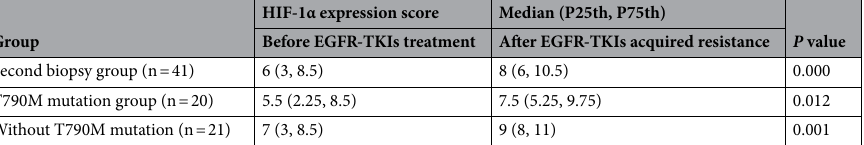
Table 3. The expression of HIF-1α in NSCLC tissues before receiving EGFR-TKIs treatment and after gaining EGFR-TKIs acquired resistance for patients receiving a second biopsy.